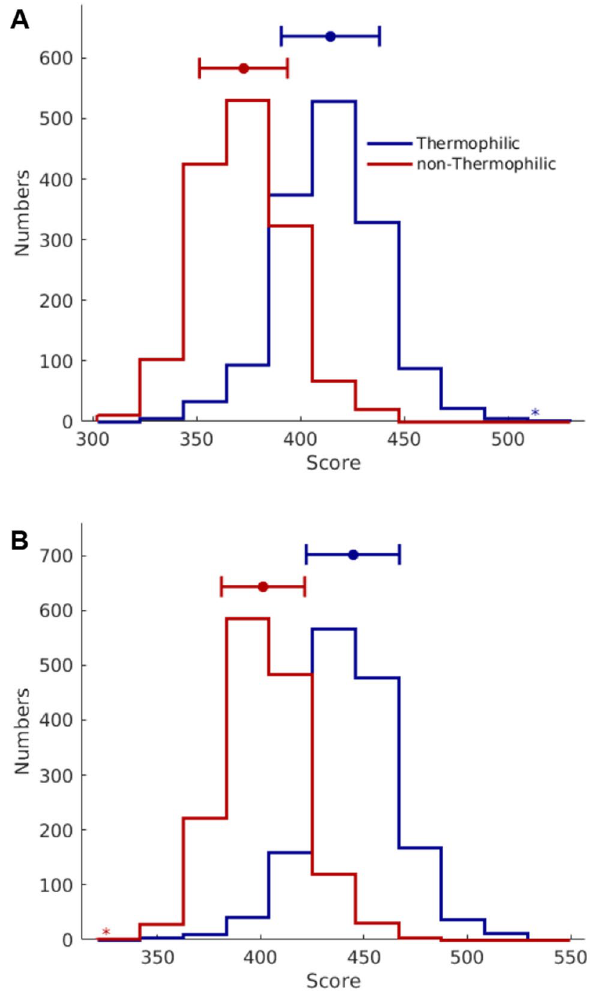
Figure 3. Histogram plot represent scores of thermophilic and non-thermophilic proteins as derived from SCMTPP using initial ( A ) and optimized ( B ) dipeptides propensity scores on the training dataset where the mean and standard deviation are indicated by bars and closed circles,